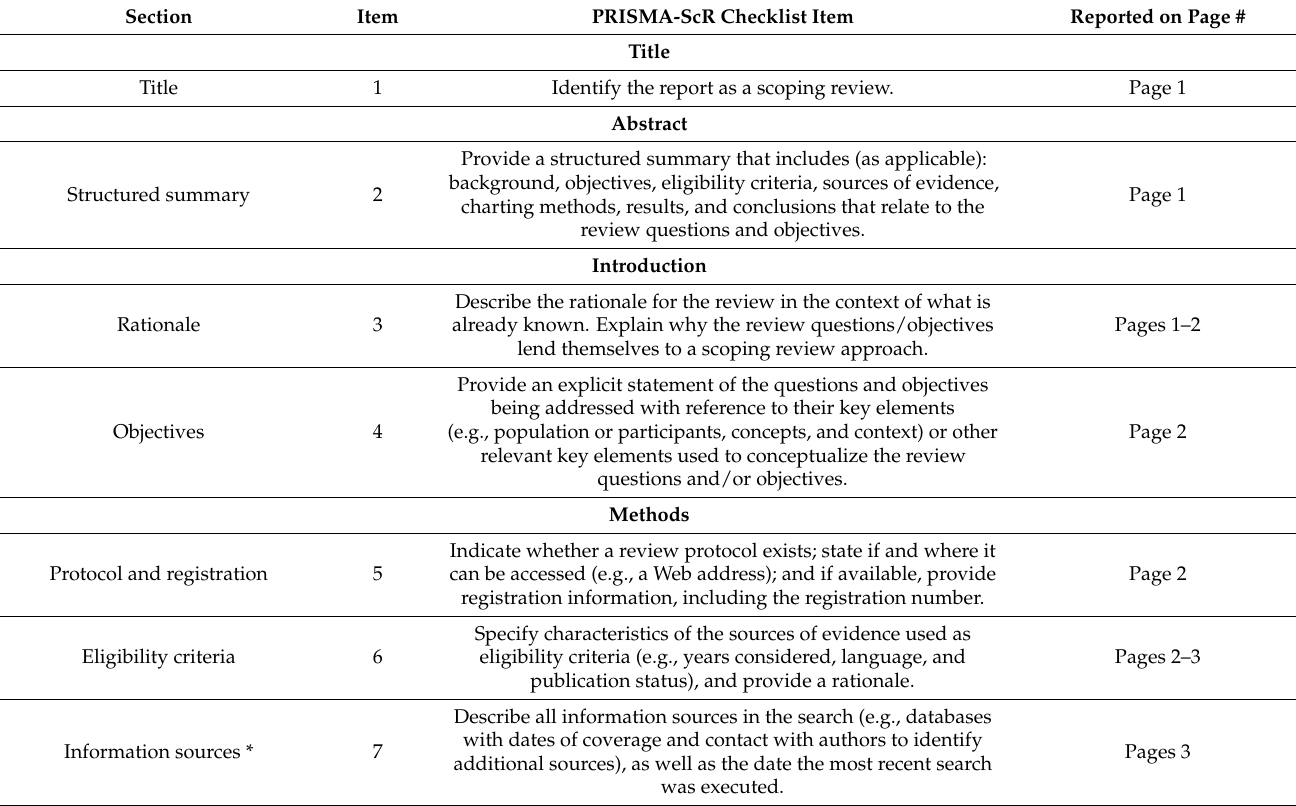
Table A1. Preferred Reporting Items for Systematic Reviews and Meta-Analyses Extension for Scoping Reviews (PRISMA-ScR) Checklist